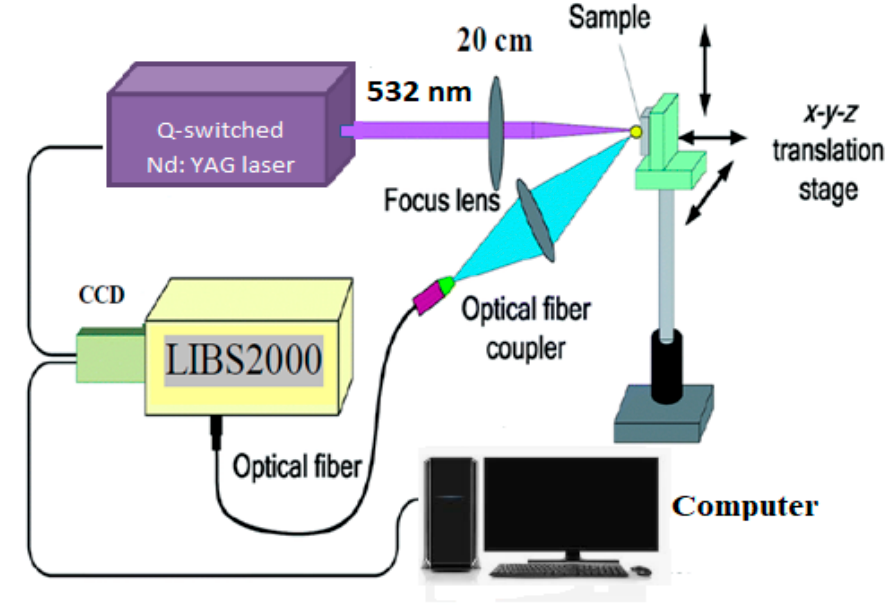
Figure 1. Schematic arrangement for LIBS2000+ detection system, showing the laser focused beam, plasma plume, and optical routing and detection of emission line from the plasma.